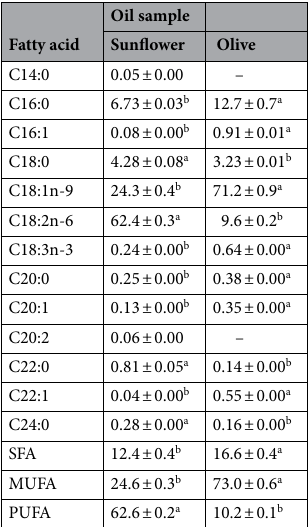
Table 1. Fatty acid composition (%w/w) of the vegetable oils studied. Means ± SD (standard deviation) within a row with the same lowercase letters are not significantly different at p < 0.05. SFA: Saturated fatty acids; MUFA: Monounsaturated fatty acids; PUFA: Polyunsaturated fatty